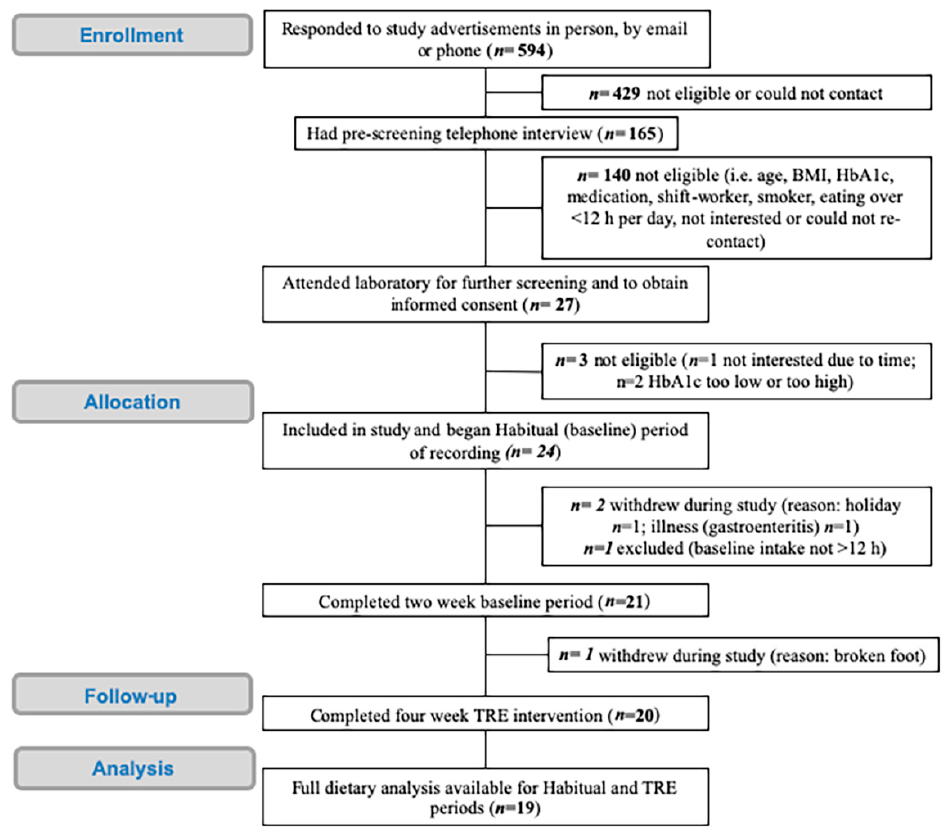
Figure 2. Consolidated Standards of Reporting Trials (CONSORT) flow diagram of participant inclusions. Table 1. Participant characteristics of participants with type 2 diabetes who completed the